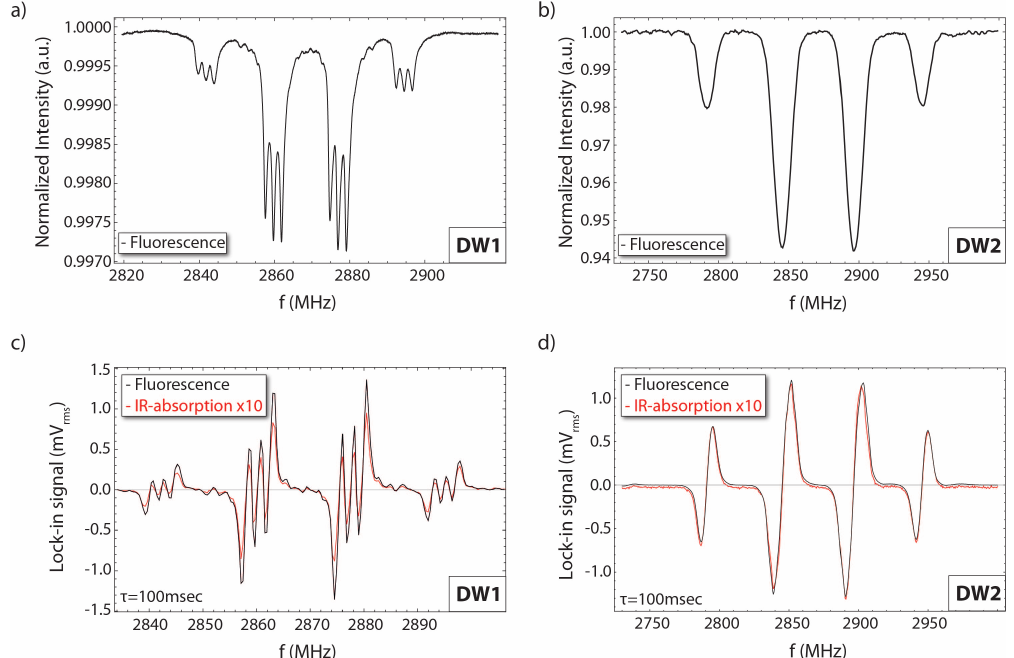
Figure 4. Continuous-wave optically detected magnetic resonance (ODMR) spectra obtained from the emitted fluorescence from ( a ) DW1, and ( b ) DW2. Frequency-modulation spectroscopy of ODMR spectra in fluorescence (black lines) and absorption (red lines) for ( c ) DW1 and ( d ) DW2. See text for further details. All presented data were obtained with an external applied magnetic field aligned along the diamond’s [111] crystal-axis under continuous pumping and MW